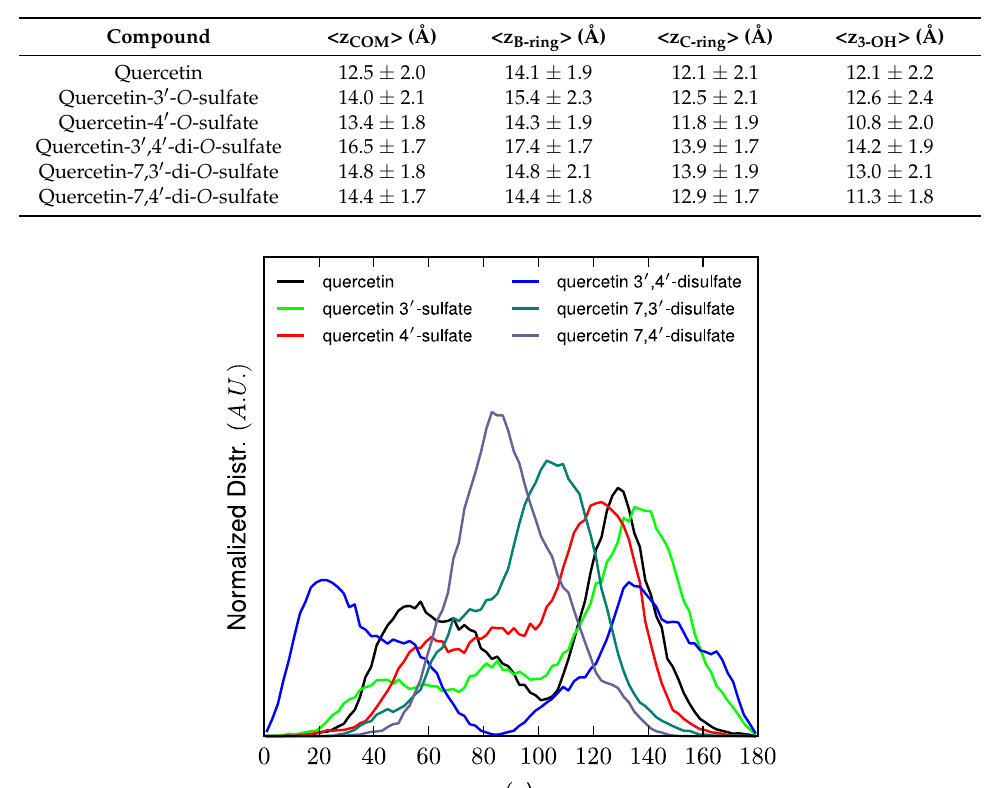
Table 6. Distance of center-of-mass (<z COM >), B-ring (<z B-ring >), C-rings (<z C-ring >), and 3-OH group (<z 3-OH >) of quercetin sulfates to center of POPC lipid bilayer.